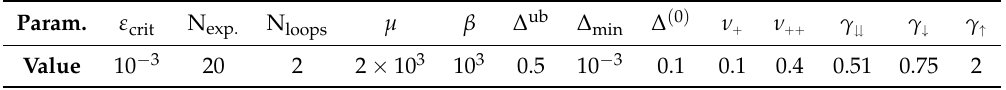
Table 2. Parameters for Figure 2, radii relative to [ 0,1 ] n . Param.